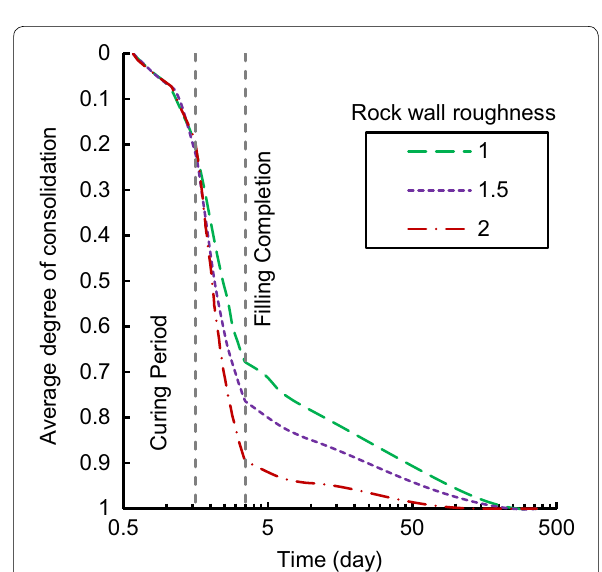
Fig. 17 Effect of rock wall roughness on the consolidation process of